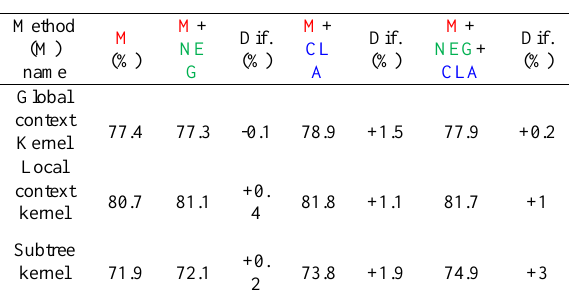
Table 6. Obtained results for 10-fold cross validation for three original kernel methods with combination of negation and clause related feature sets in terms of f-